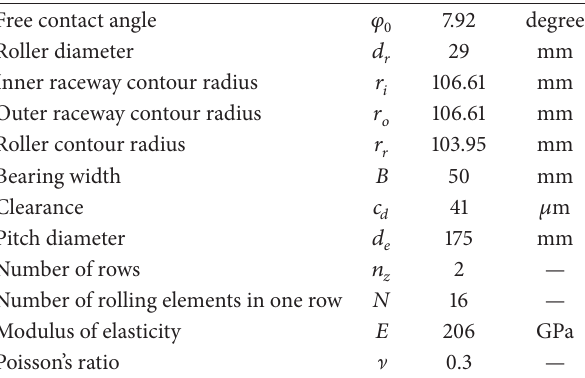
Table 1: Dimensions and parameters of the spherical roller bearing. Free contact